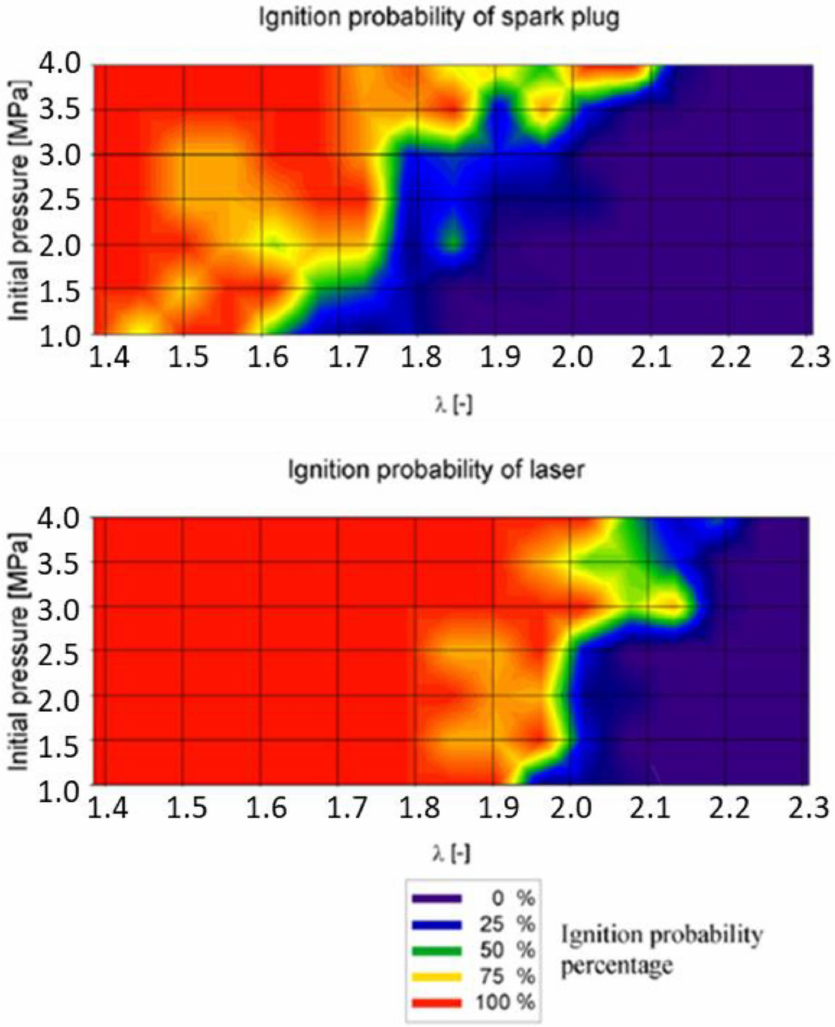
Figure 6. Comparison of the ignition probability of the laser ignition and conventional spark plug